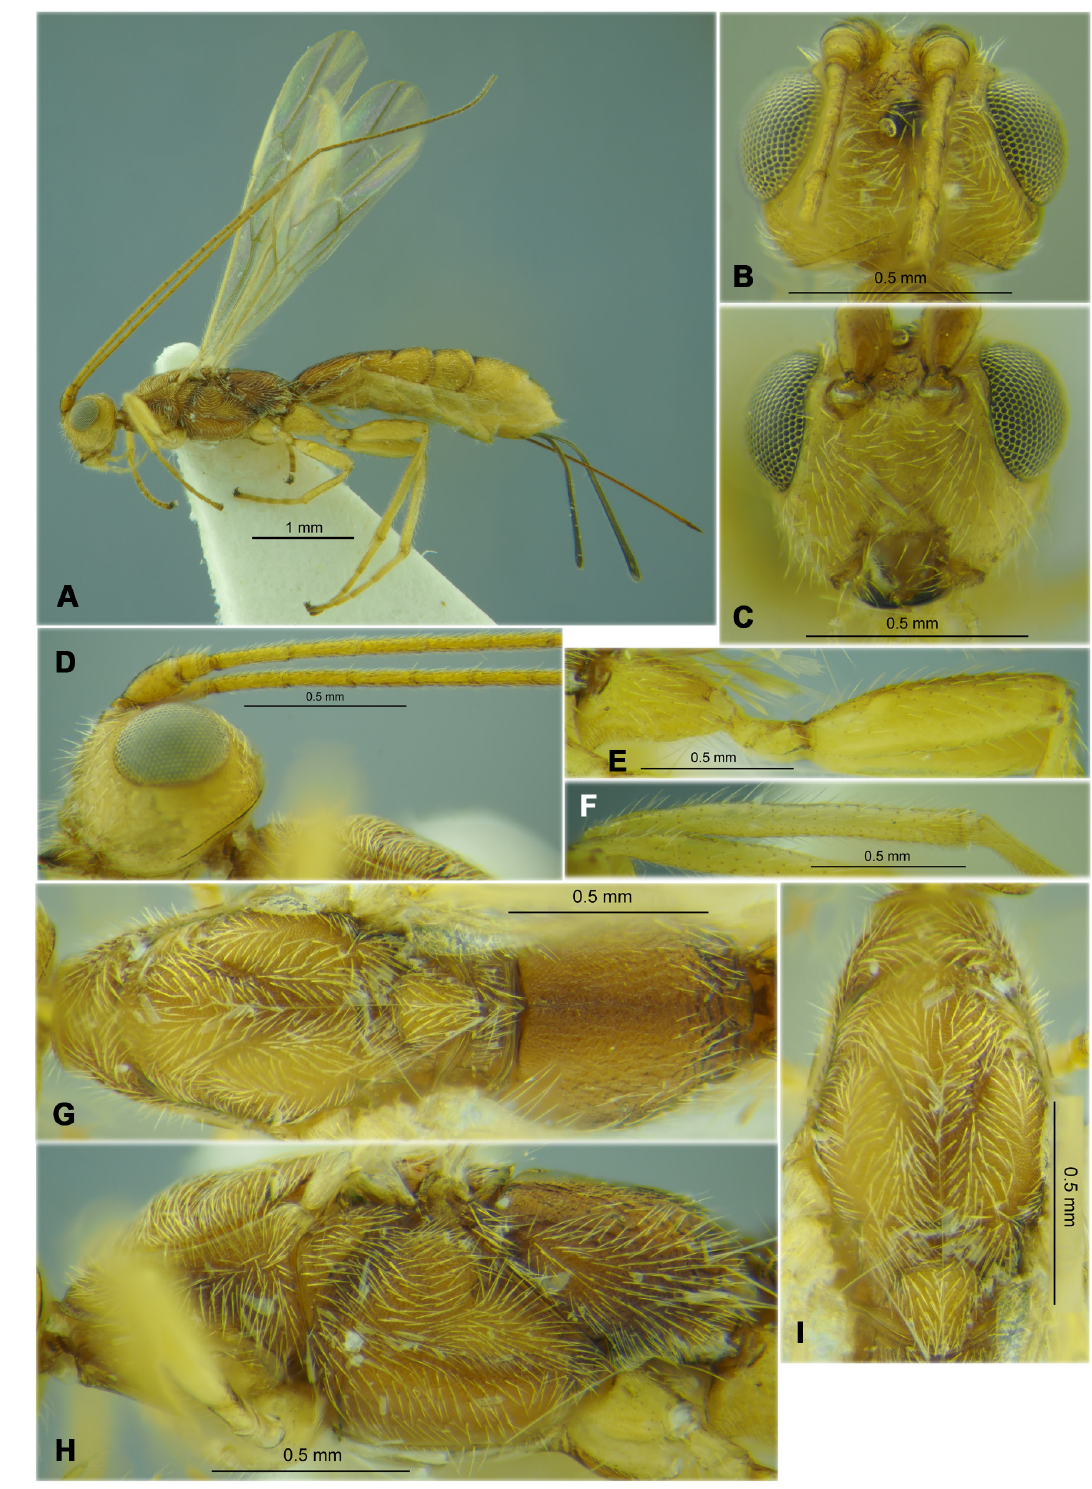
Fig. 57. Rhaconotus ( Rh. ) scirpophagae Wilkinson, 1927, ♀ (RMNH). A . Habitus, dorsal view. B . Head, dorsal view. C . Head, front view. D . Head and basal segments of antenna, lateral view. E . Hind coxa and femur. F . Hind tibia. G . Mesosoma, dorsal view. H . Mesosoma, lateral view. I . Mesoscutum and scutellum, dorsal